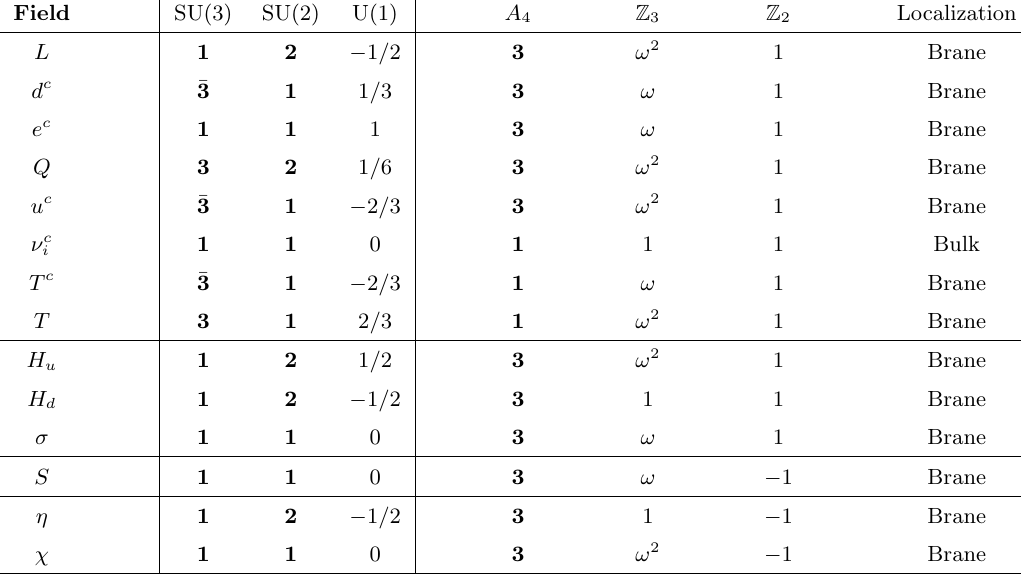
Table 1 . Field content of the